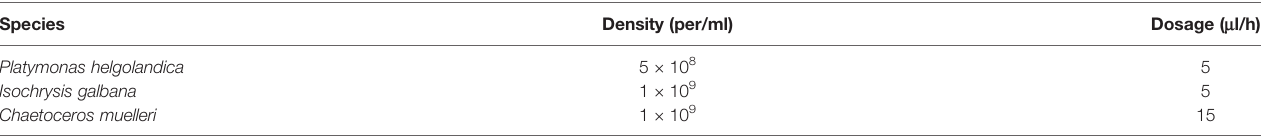
TABLE 5 | Mixed algae used to ripen M. lateralis .